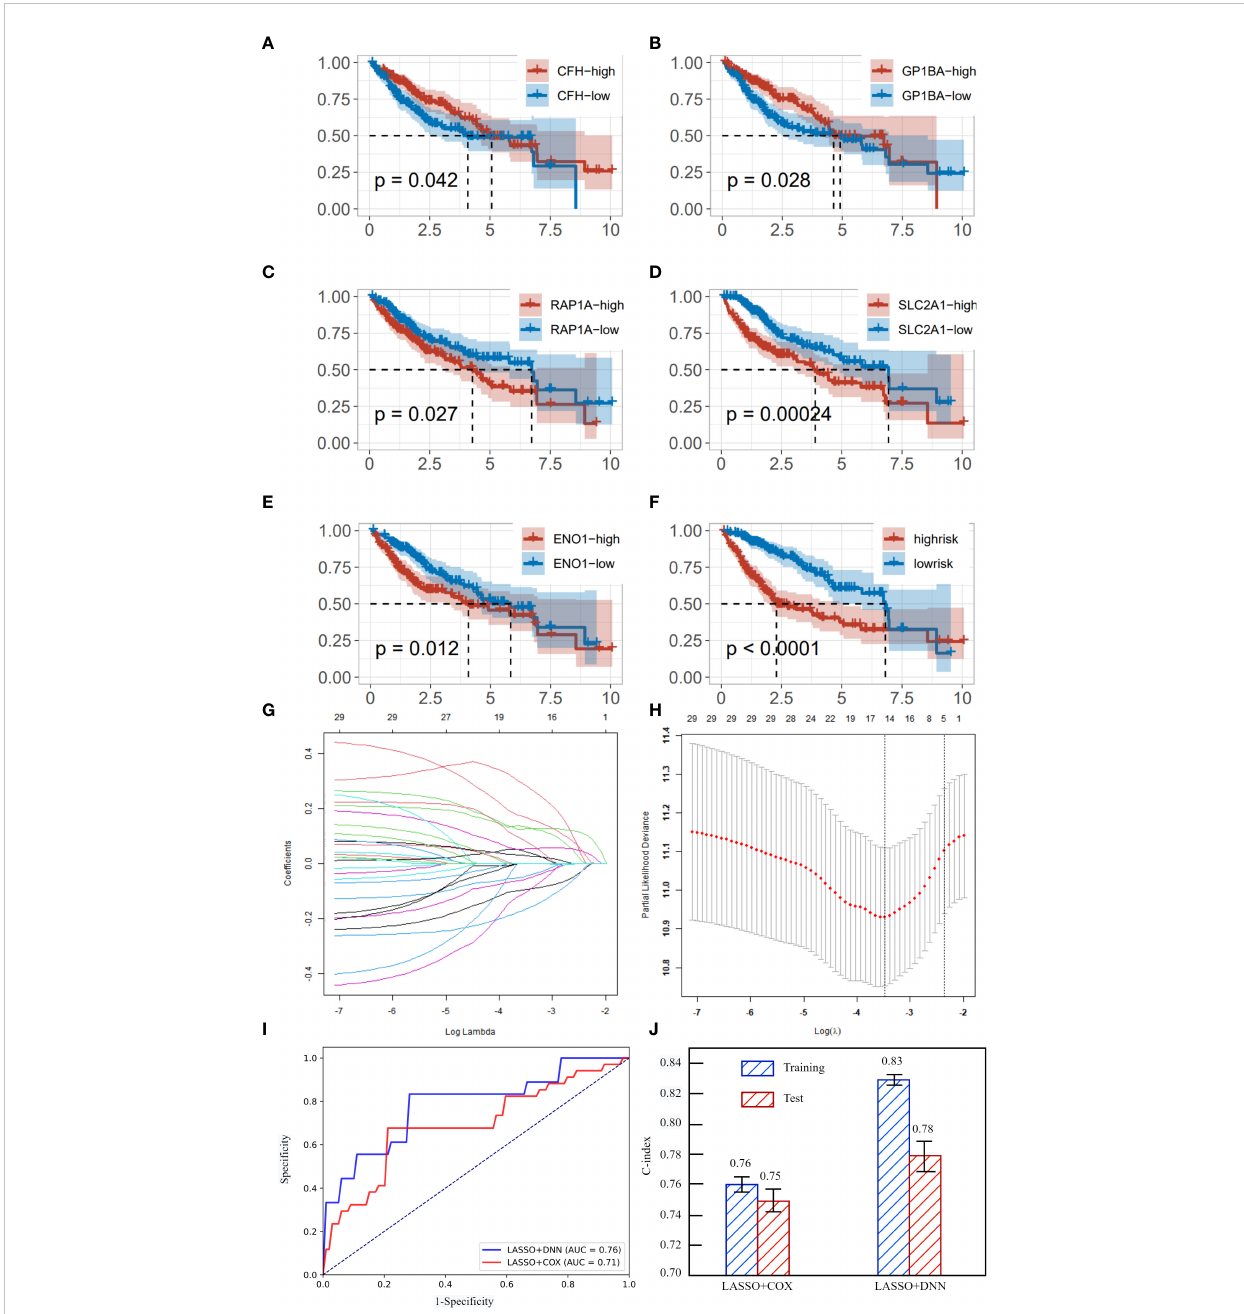
FIGURE 4 (A) survival curve in different expression of CFH. (B) survival curve in different expression of GP1BA. (C) survival curve in different expression of RAP1A. (D) survival curve in different expression of SLC2A1. (E) survival curve in different expression of ENO1. (F) survival curves of high risk and low risk. (G) coef fi cients of gene under different lambda. (H) partial likelihood deviance under different lambda. (I) The AUC curves of LASSO+DNN and LASSO+COX regression. (J) C-index and its standard deviation of different